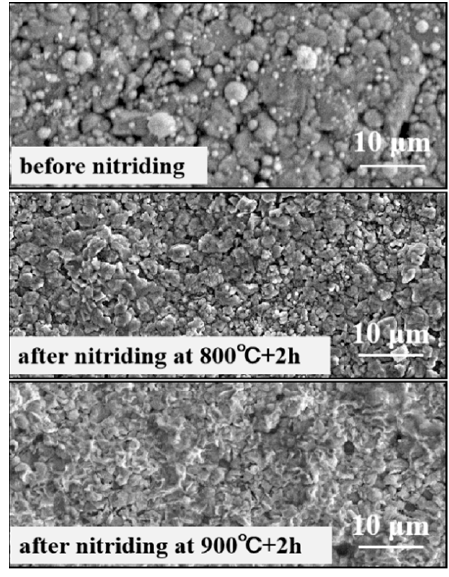
Figure 3. The surface SEM images of the Ti/Cu multilayer film before and after nitriding.